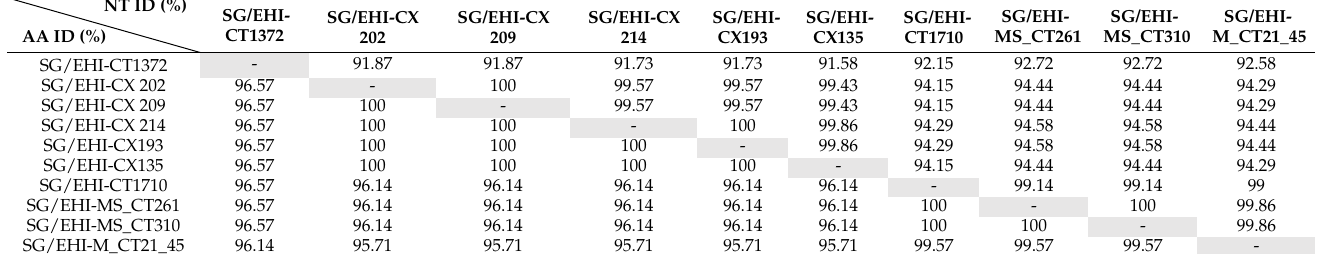
Table 3. Percentage nucleotide and amino acid sequence similarity of the envelope gene sequences obtained from ten mosquito pools. Nucleotide sequence identities (NT ID) are in the upper right triangular area above the shaded cells and amino acid sequence identities (AA ID) are in the lower left triangular area.